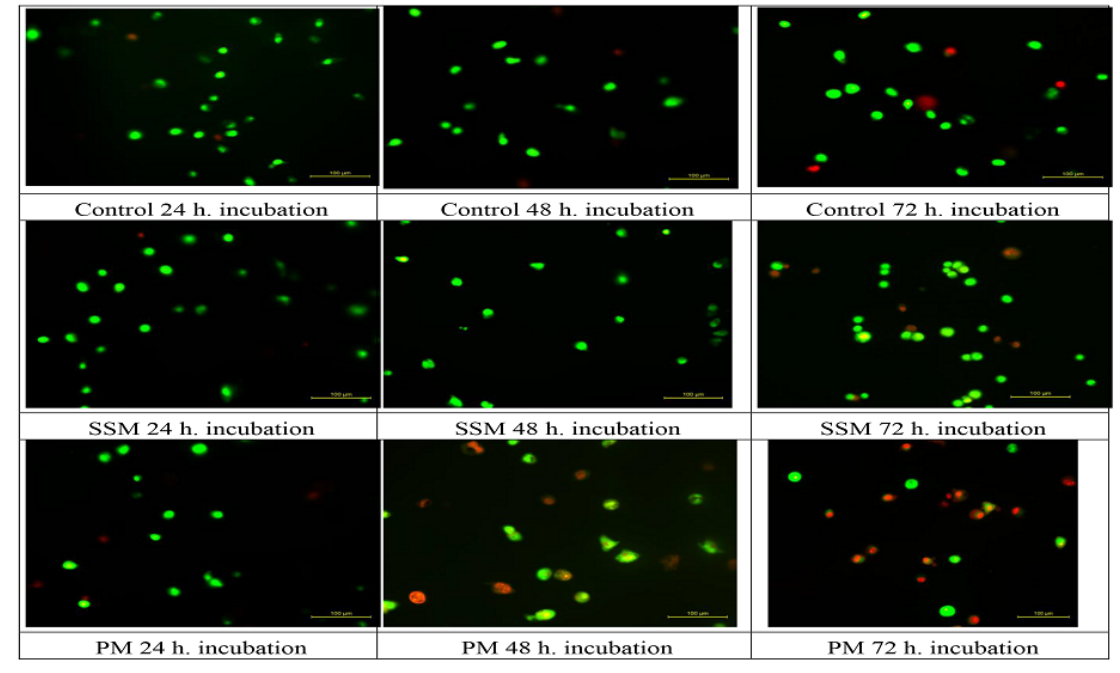
Figure 7. Different morphological patterns of cell death induced by 4 mg/mL of SSM and 1 mg/mL of PM on L-929 cells compared to non-treated ones after 24, 48 and 72 h incubation. Green live cells show normal morphology; green early apoptotic cells show nuclear margination and chromatin condensation. Late orange apoptotic cells showed fragmented chromatin and apoptotic bodies. Necrotic cells stain uniformly red.